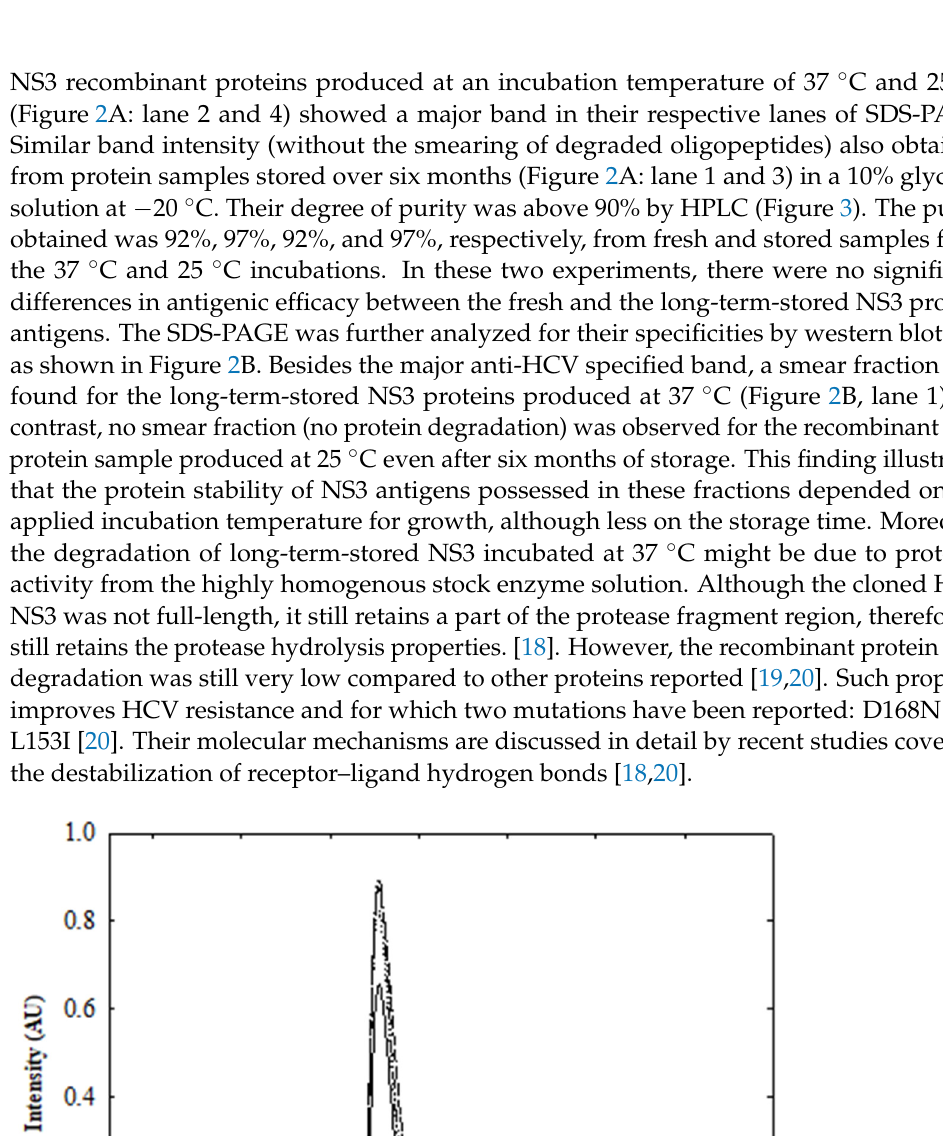
NS3 recombinant proteins produced at an incubation temperature of 37 ◦ C and 25 ◦ C (Figure 2A: lane 2 and 4) showed a major band in their respective lanes of SDS-PAGE.